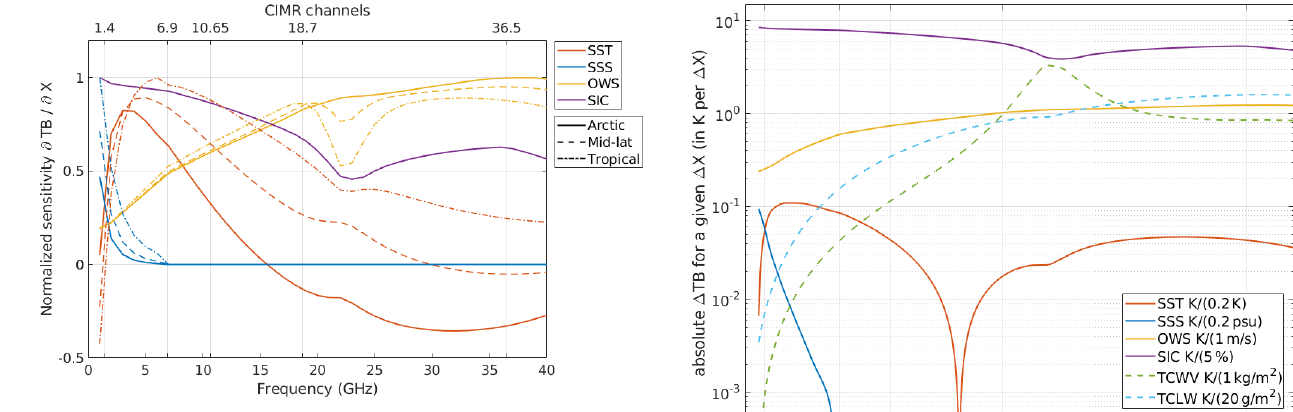
Figure 3. Normalized sensitivities of the satellite measurements to the surface parameters as a function of frequency for the different environments at 55 ◦ incidence angle, under clear sky conditions. Solid lines: Arctic. Dashed lines: mid-latitudes. Dotted lines: tropi- cal.